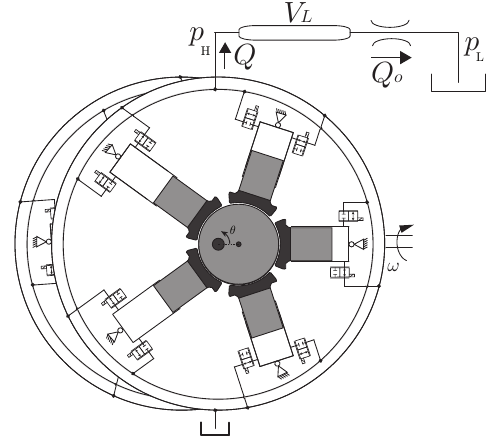
Figure 9: Illustration of the simple load system used for pressure control of the digital displacement